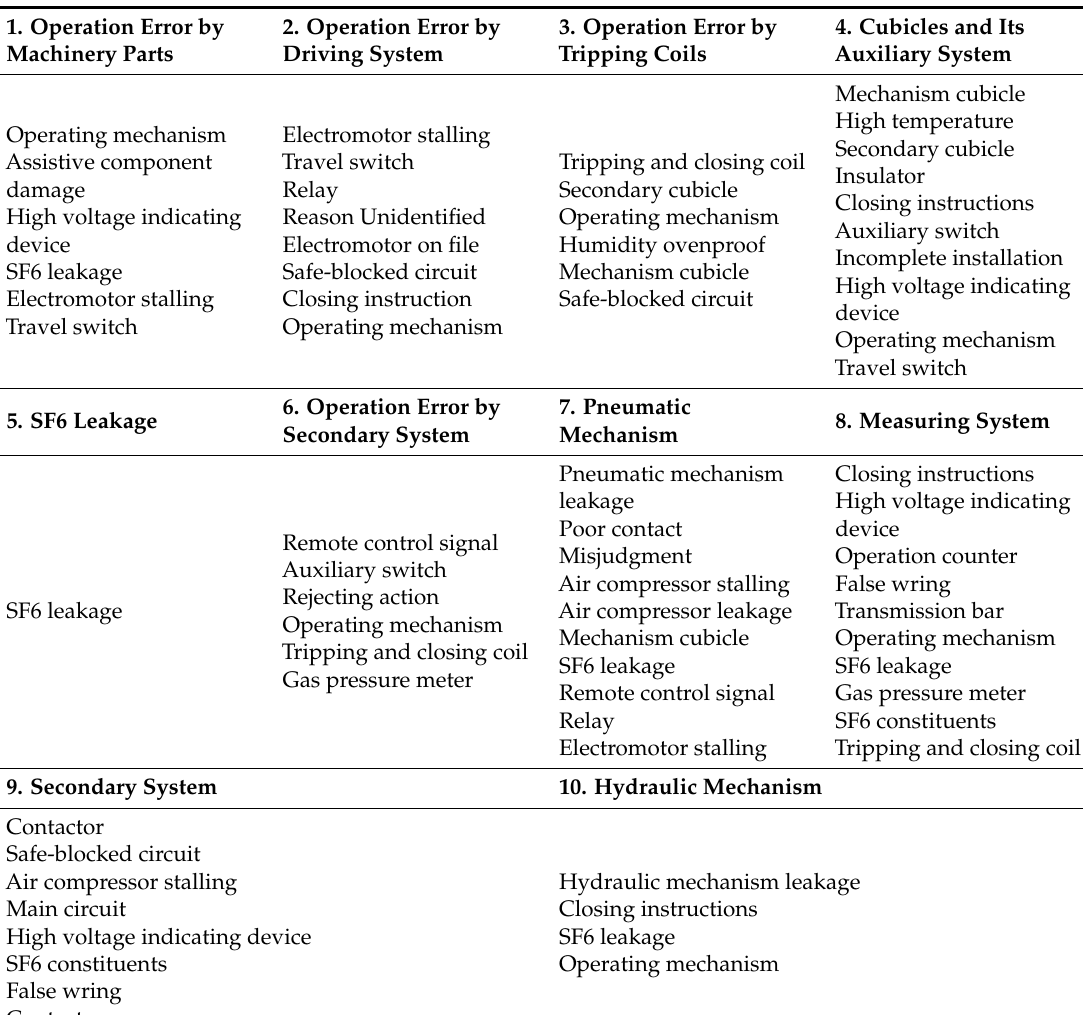
Table 5. Top failures in each failure